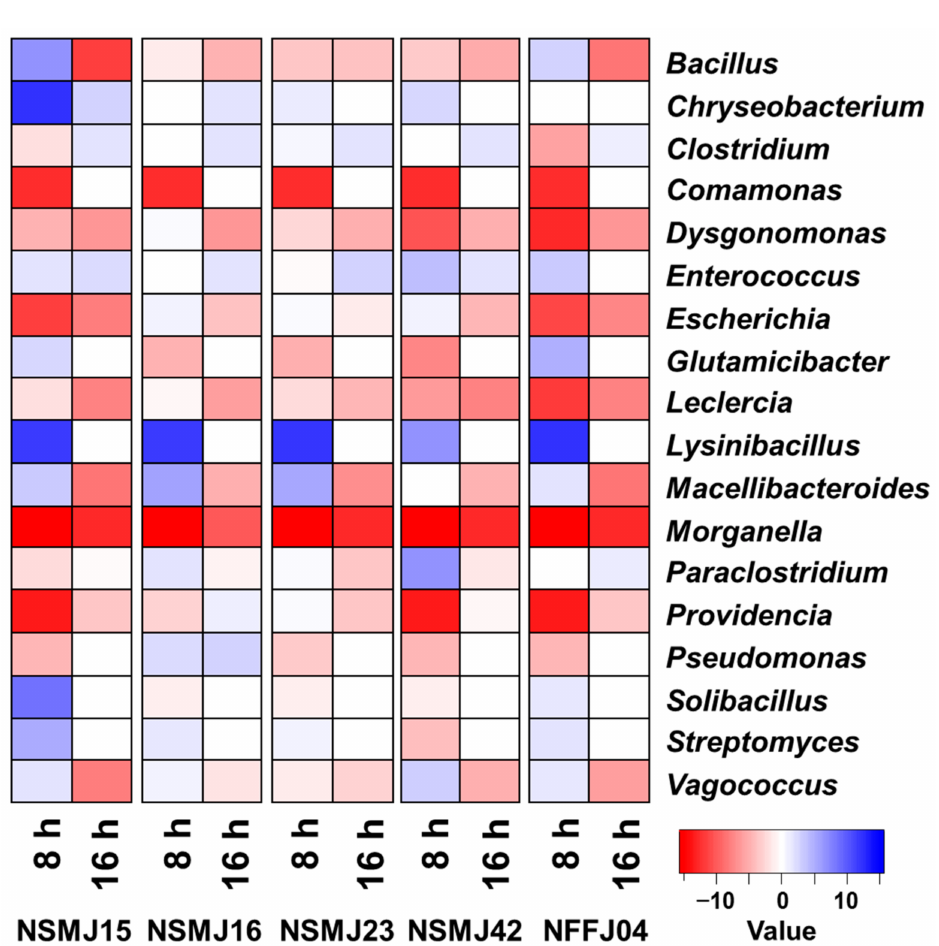
Figure 3. Heat map showing log2-fold change relative to controls at the genus level. Red and blue cells indicate decreased and increased abundance due to treatment,